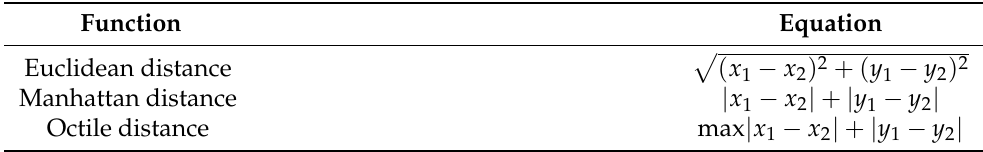
Table 2. Most Common Types of Heuristic Functions Used In Path Planning Algorithms.